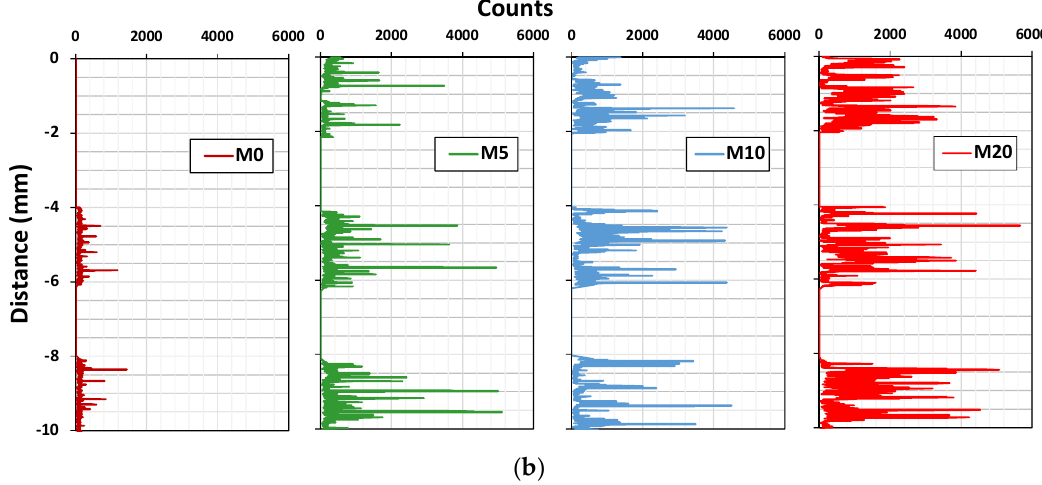
Figure 12. Ti counts on the top, middle, and bottom surfaces of sliced sections 10 mm in thickness (the line scans are at 2-mm intervals): ( a ) C-series samples, ( b ) M-series samples. Materials 2018 , 11 , x FOR PEER REVIEW